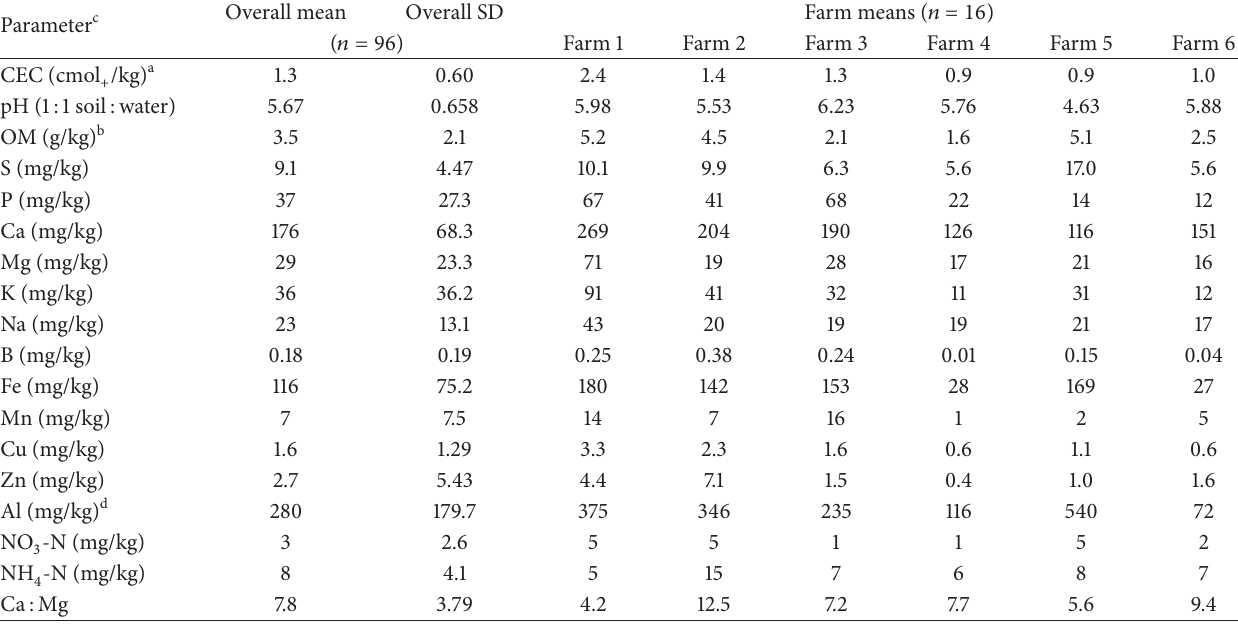
Table 1: Preexperiment soil fertility levels at 15 to 25 cm depth on six farms in C´at Trinh Commune. Overall Parameter c